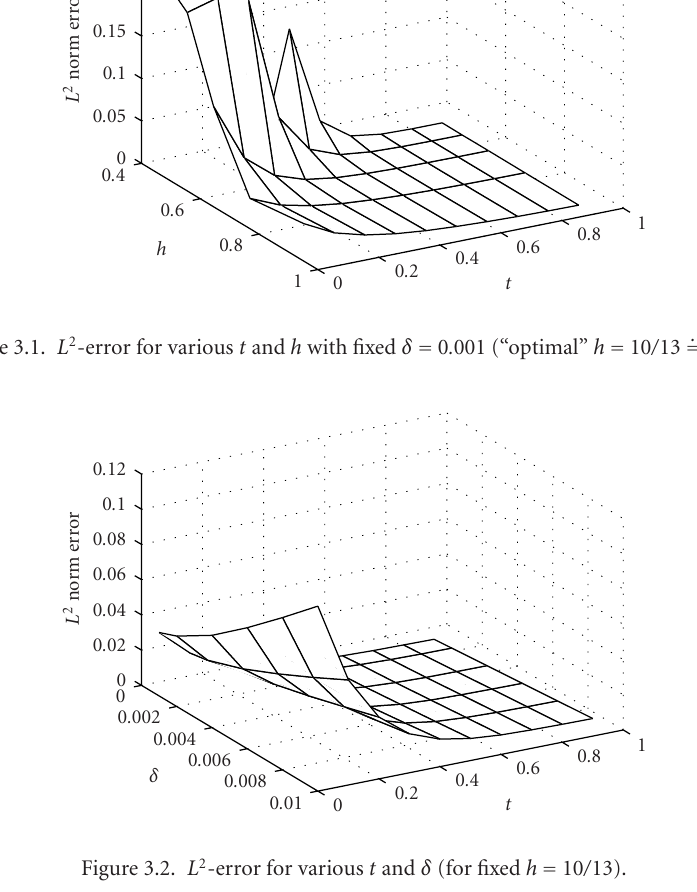
Figure 3.2. L 2 -error for various t and δ (for fixed h = 10 /